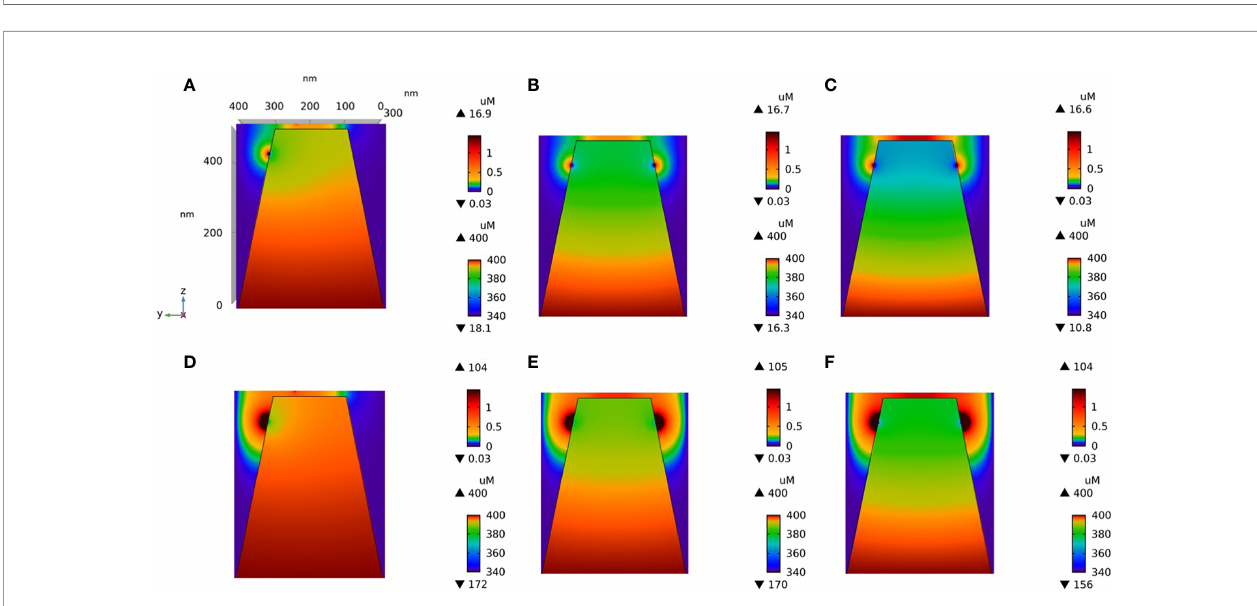
FIGURE 6 | Analysis of the in fl uence of the presence of IP 3 Rs and of the value of the Ca 2+ diffusion coef fi cient in the ER, D S . (A) Ca 2+ concentration around the luminal mouth of an IP 3 R for the two values of D S considered in the simulations. The largest this value, the fastest the replenishment around an open channel. (B) Fluxes through open IP 3 Rs for the two values of D S considered in the simulations. Because of faster replenishment around an open channel when D S is larger, the concentration gradient around the two extremities of the channel pore is larger, and hence the fl ux.